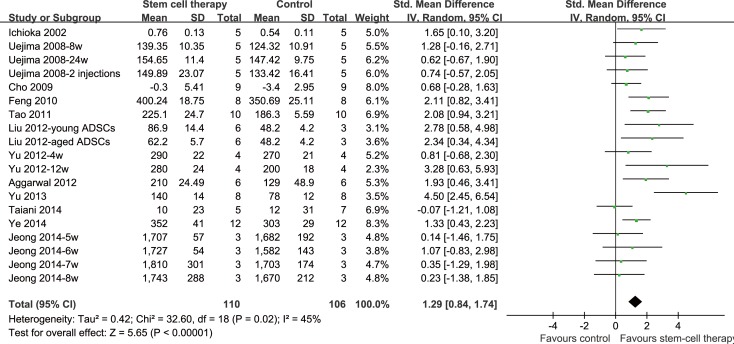
Forest plot of the meta-analysis of standardized mean difference of bone mineral density by study group (stem cell based treatment- vs. control group).BMD, Bone mineral density; SD, standard deviation; CI, confidence interval; df, degrees of freedom